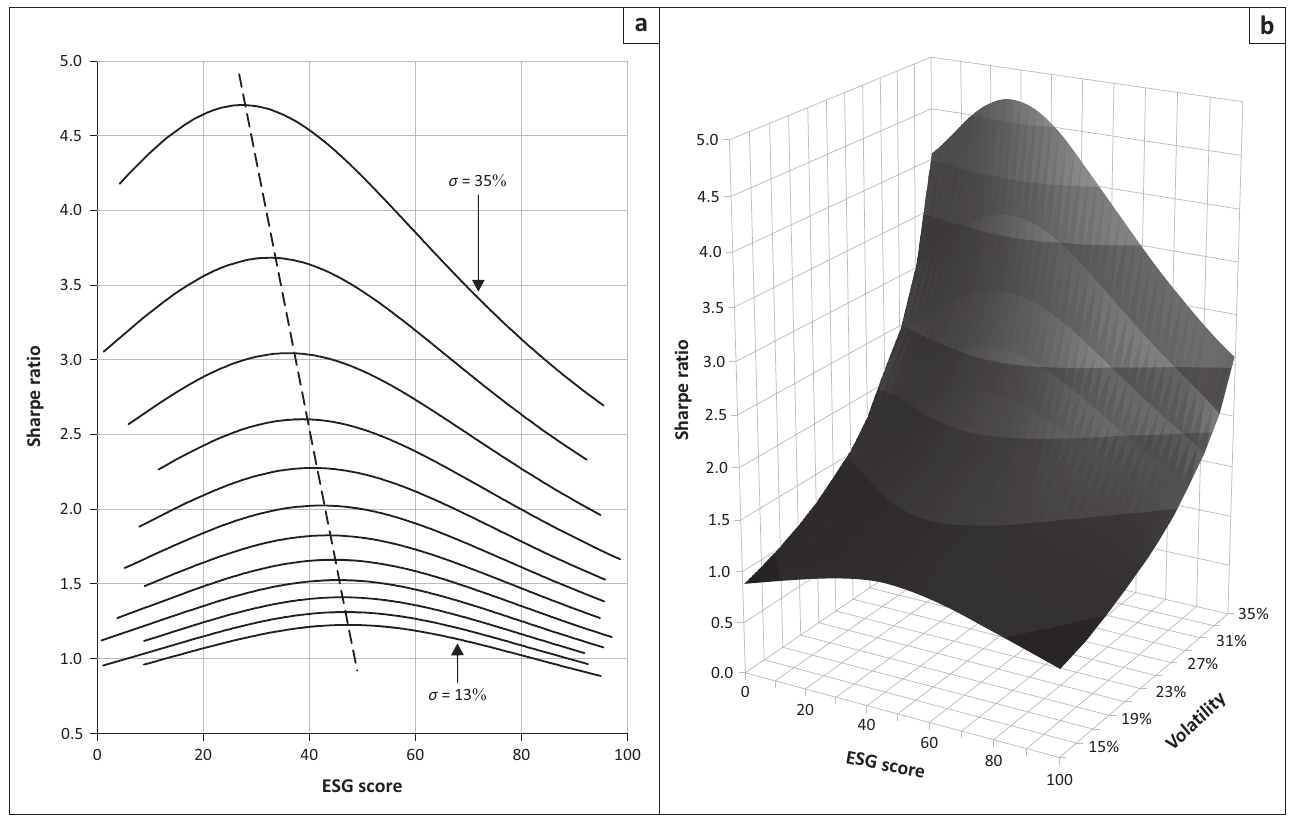
FIGURE 5: Sharpe ratio versus environmental, social and governance score as a function of volatility (increasing from the uppermost to lowest curve) in (a) two and (b) three dimensions.